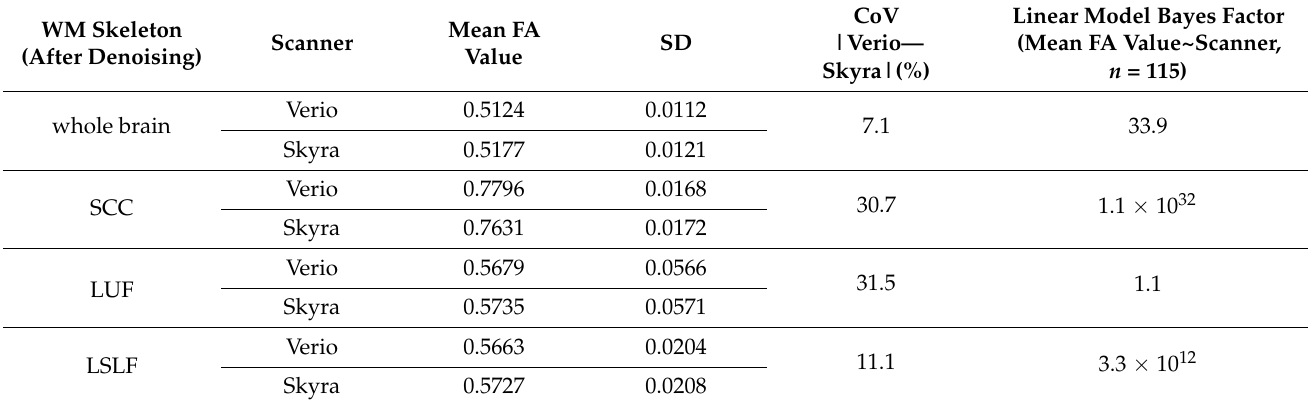
Table 1. Mean FA values of the white matter skeleton at the whole-brain level and in different ROIs (CMRR sequence, after denoising). Bayesian linear modelling shows significant scanner differences for ROIs in the centre (SCC) and long white matter tracts (LSLF) but not for ROIs with curved lateral tracts